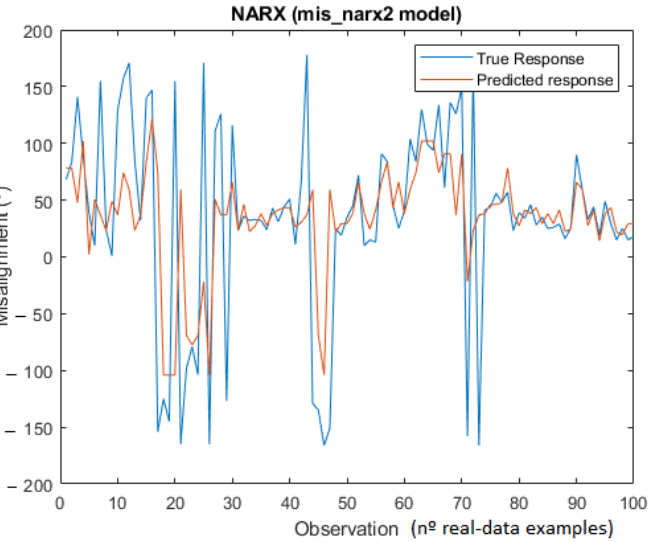
Figure 9. Predicted vs. real output for mis_narx2 model for the first 200 data from 2020.